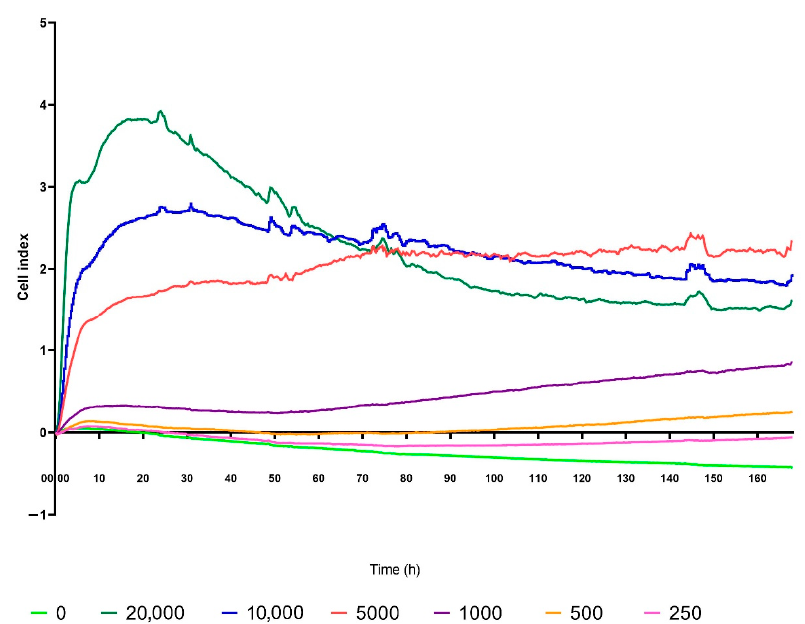
Figure 1. Identification of the optimum cell density for RT-CES measurements. The cells were seeded 250, 500, 1000, 5000, 10,000 and 20,000 per well. In this 168-h experiment, the 10,000 cells/well density was found optimal (blue curve). All experiments were performed in triplicates.